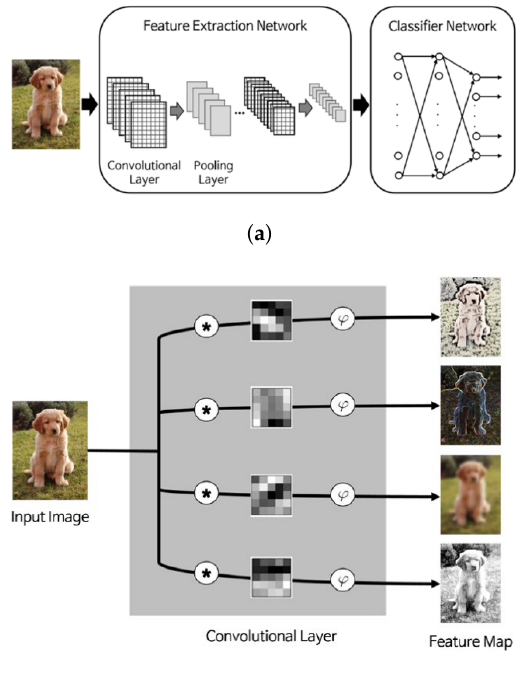
Figure 9. Reprinted by permission from [140], Springer Nature Customer Service Centre GmbH: https://www.apress.com/us/book/9781484228449 Apress by Kim, P, Copyright (2017). ( a ) Basic structure of a CNN. ( b ) convolutional